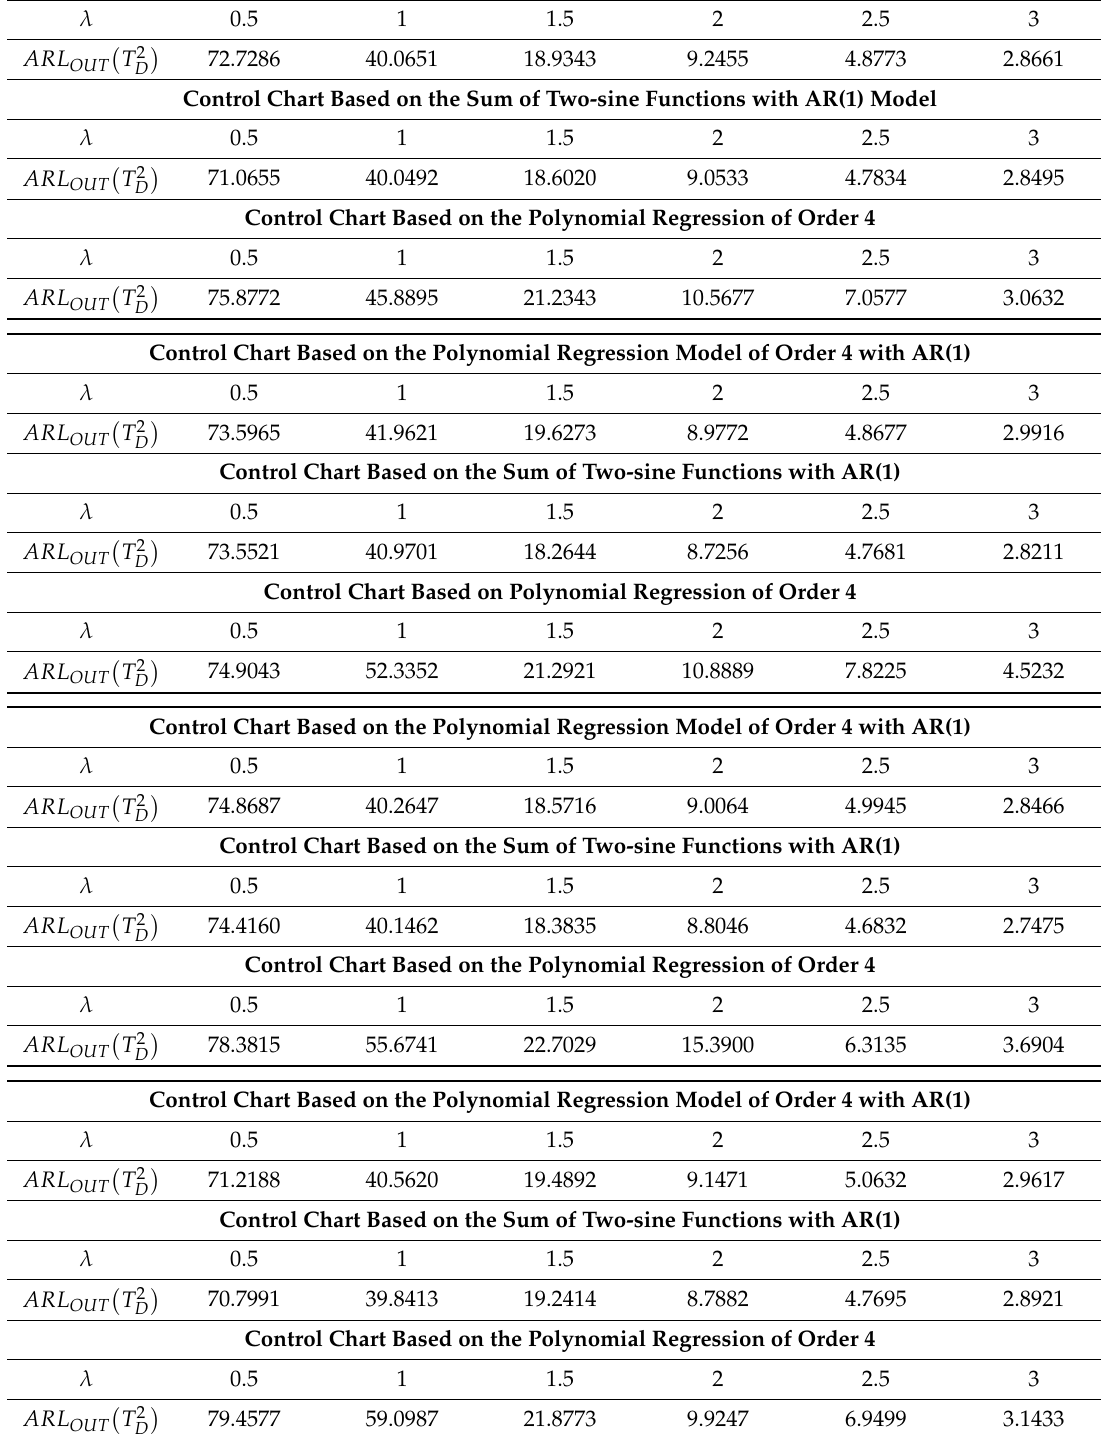
; ( c ) c 1 from c 1 to c 1 + λσ c 1